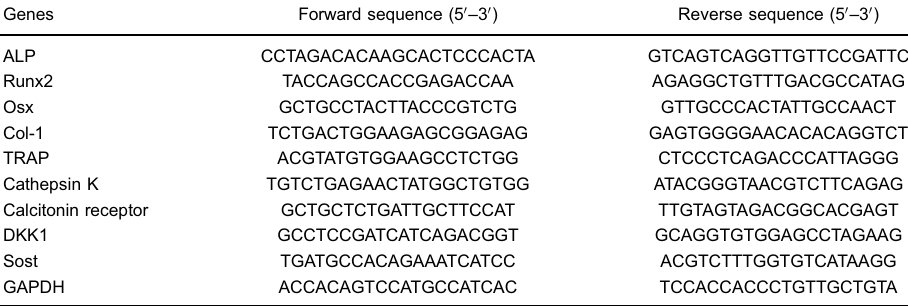
Table 1. Primer sequences used in quantitative real-time PCR